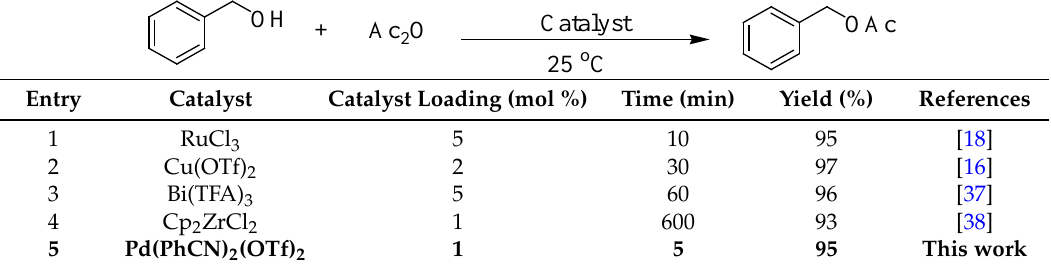
Table 2. Comparison of some acetylation methods with benzyl alcohol as substrate.